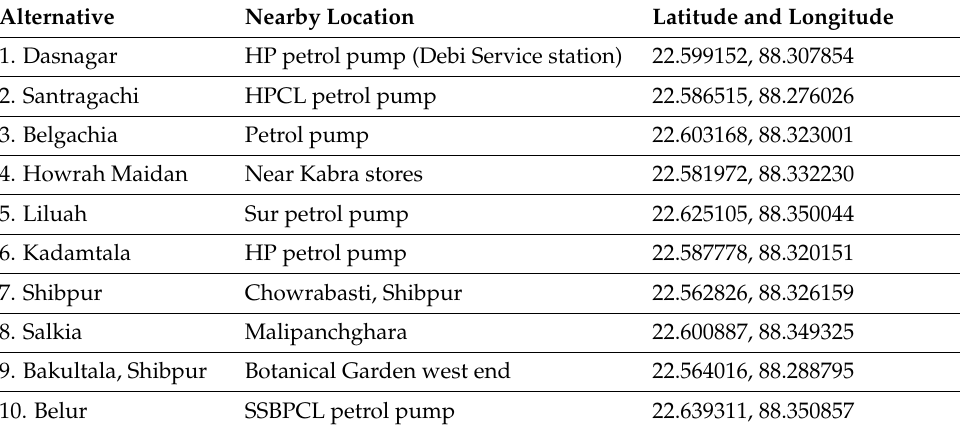
Table 2. Alternatives selected in the study and their corresponding nearby location, latitude and